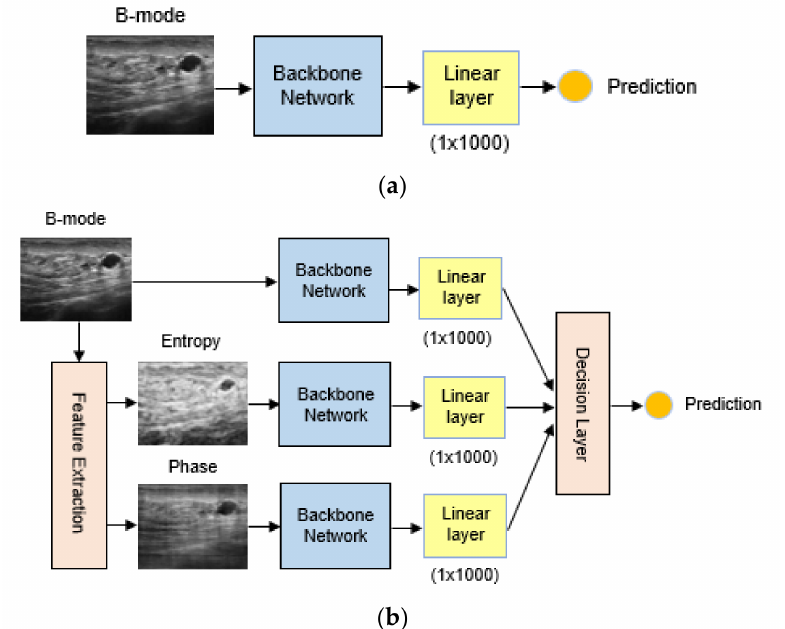
Figure 3. Overall architectures of convolutional deep neural networks. ( a ) Traditional convolutional neural network (CNN) using B-mode image only, and ( b ) proposed feature-channel CNN architecture (FC-CNN) using multiple feature